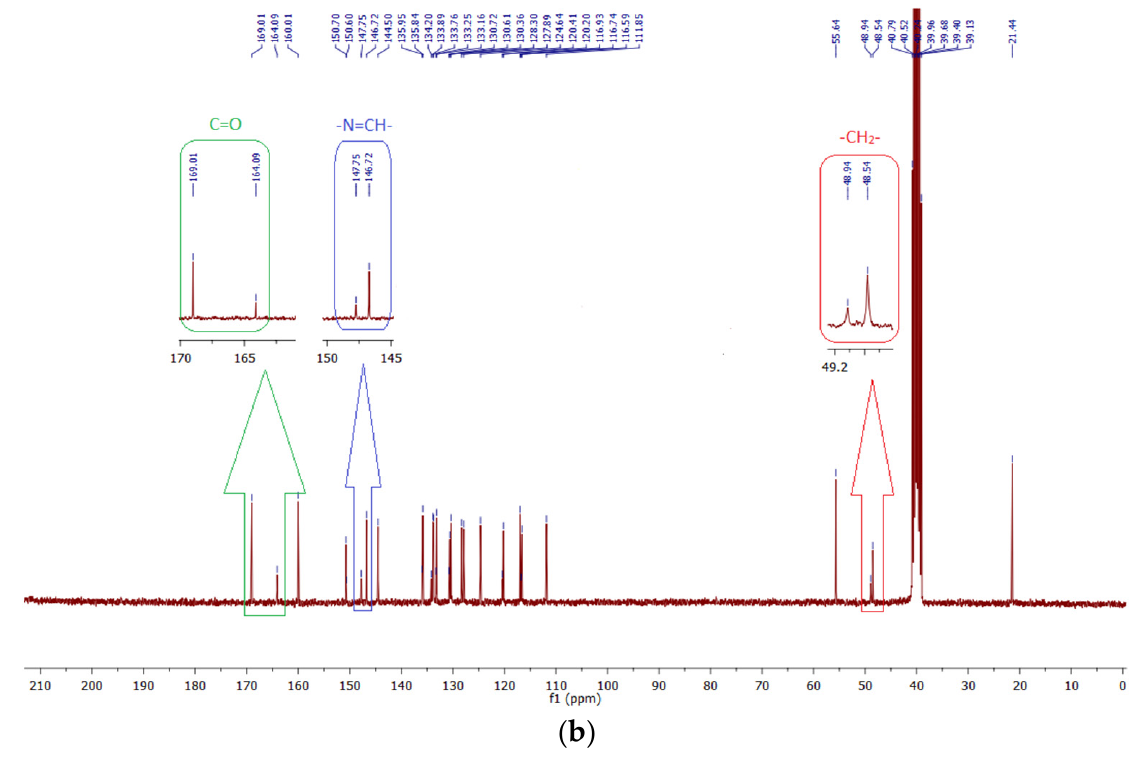
Figure 2. ( a ) 1 H NMR and ( b ) 13 C NMR spectra of N -Acylhydrazone 6k .